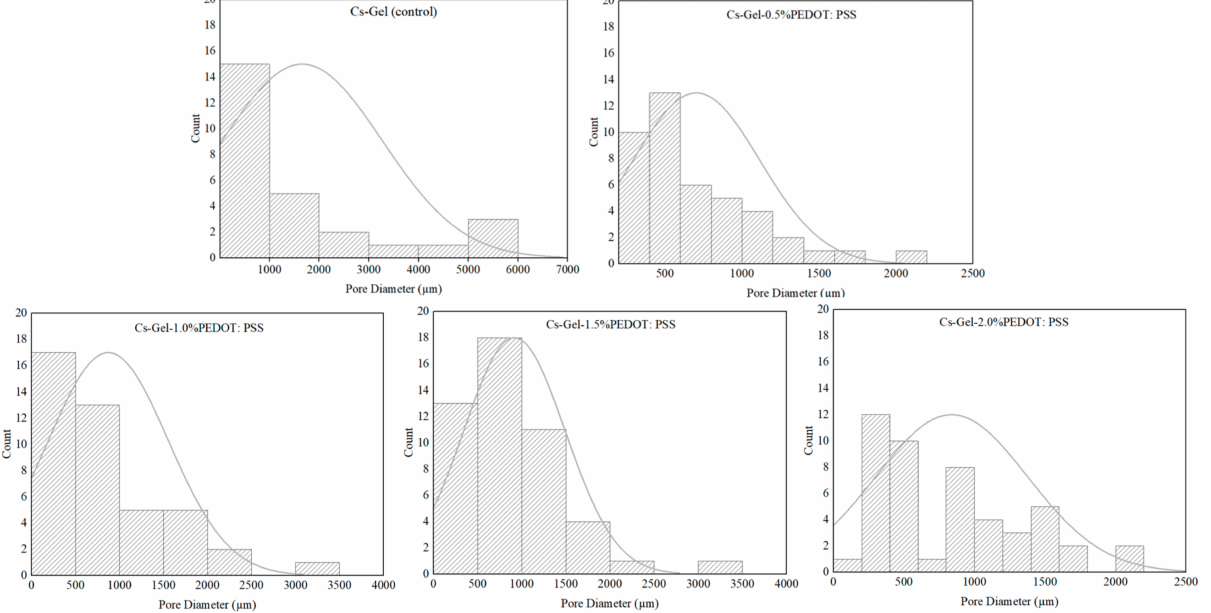
Figure 4. Pore diameter distribution graphs of all samples, analyzed via ImageJ